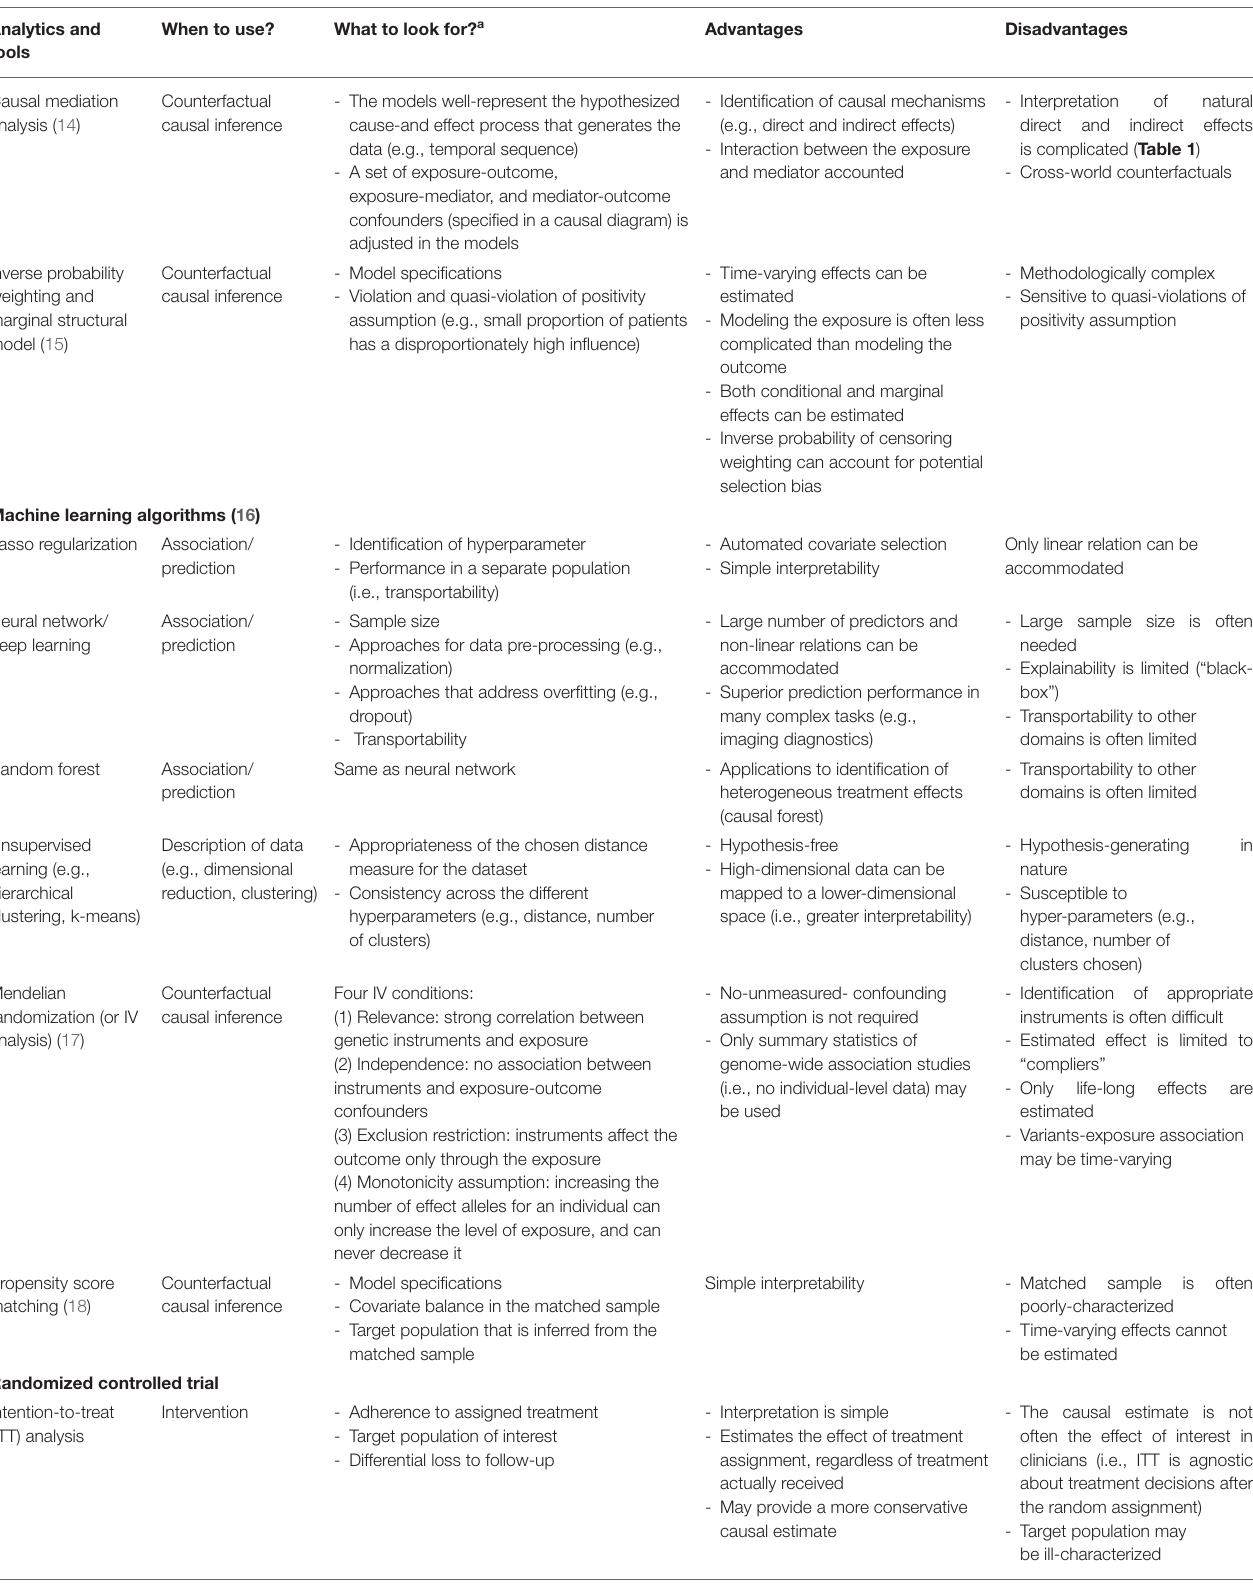
TABLE 3 | Major analytical tools used in data science. Analytics and